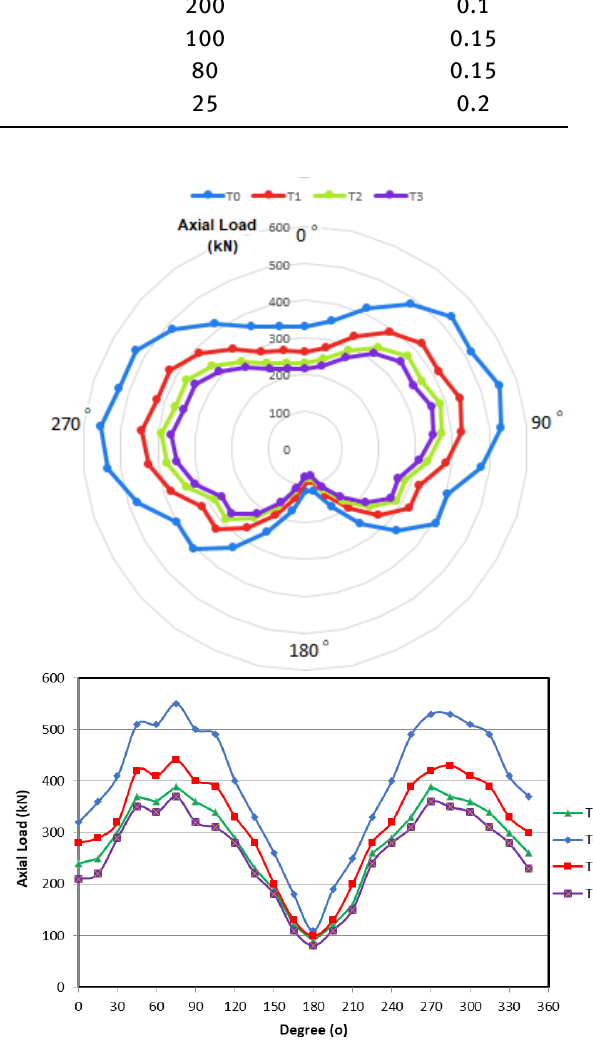
Figure 15: Comparing the axial force in different